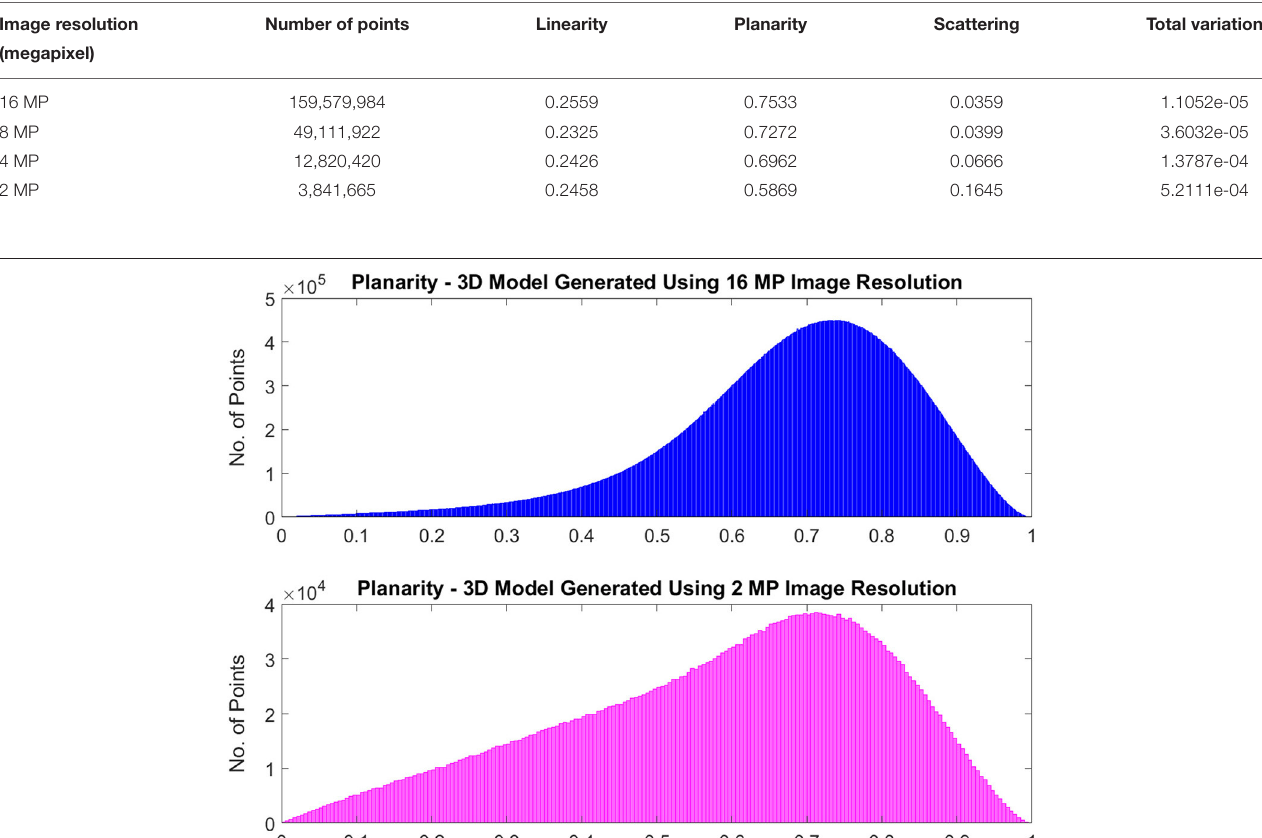
Frontiers in Built Environment |